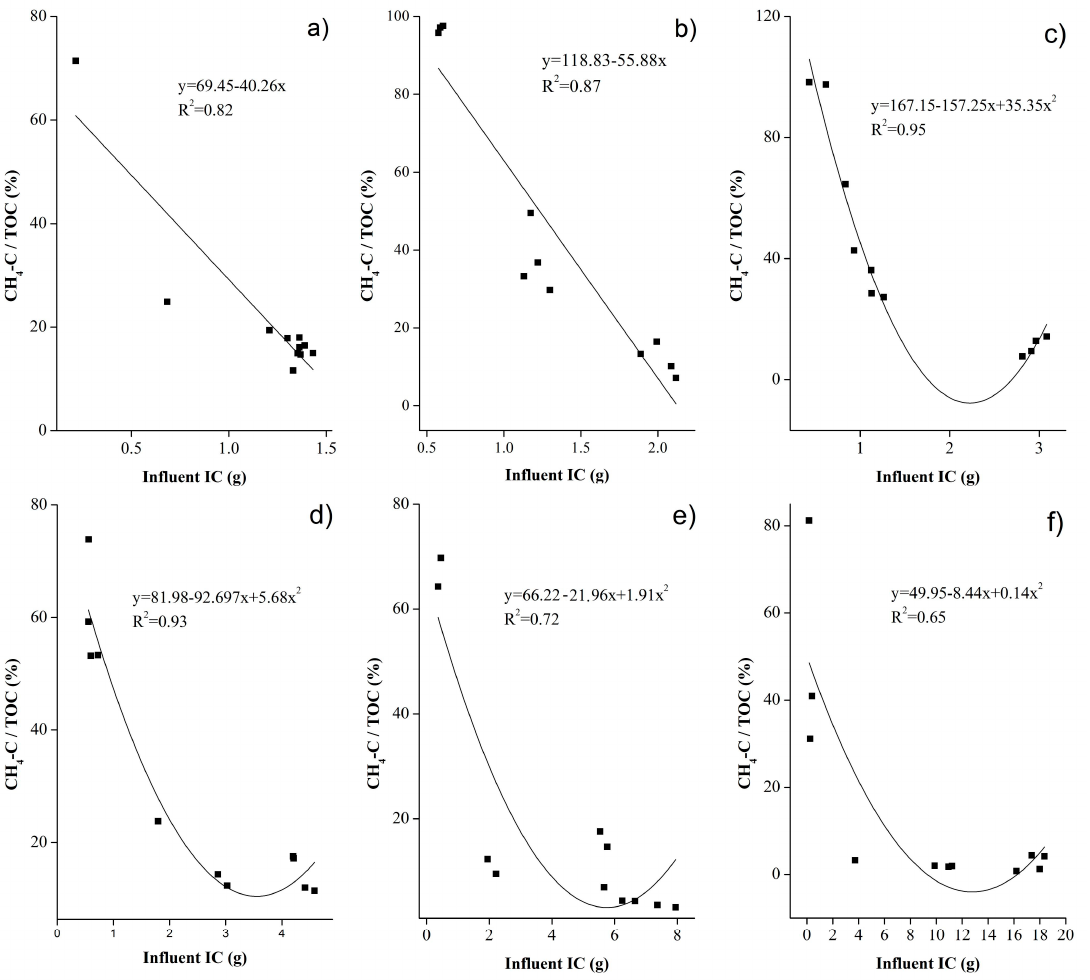
Figure 7. The relationship rate between the CH 4 -C and influent inorganic carbon (IC). ( a ) 0 mmol / L ethanol added; ( b ) 2 mmol / L ethanol added; ( c ) 4 mmol / L ethanol added; ( d ) 8 mmol / L ethanol